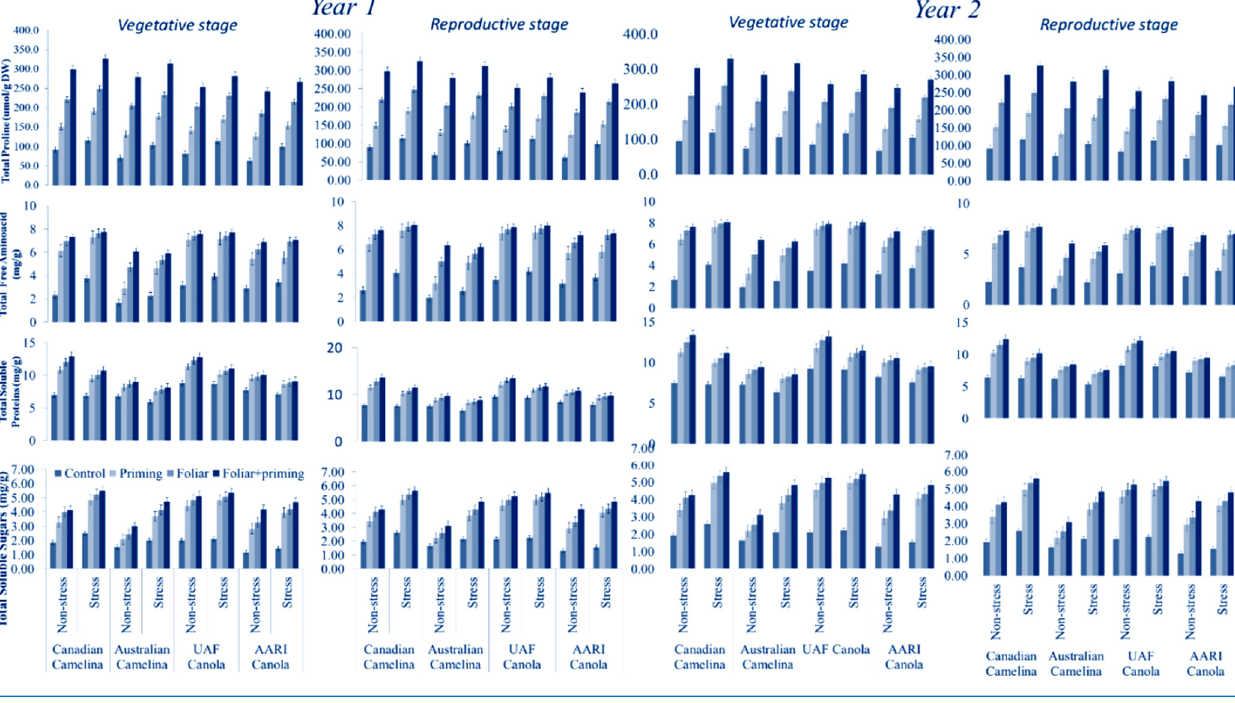
Figure 2. Impact of Se application (seed priming and foliar) on biochemical attributes at both stages (vegetative and reproductive) of oilseed crops (camelina and canola) subjected to water deficit in the year 2016 and 2017 (mean values ± S.E).